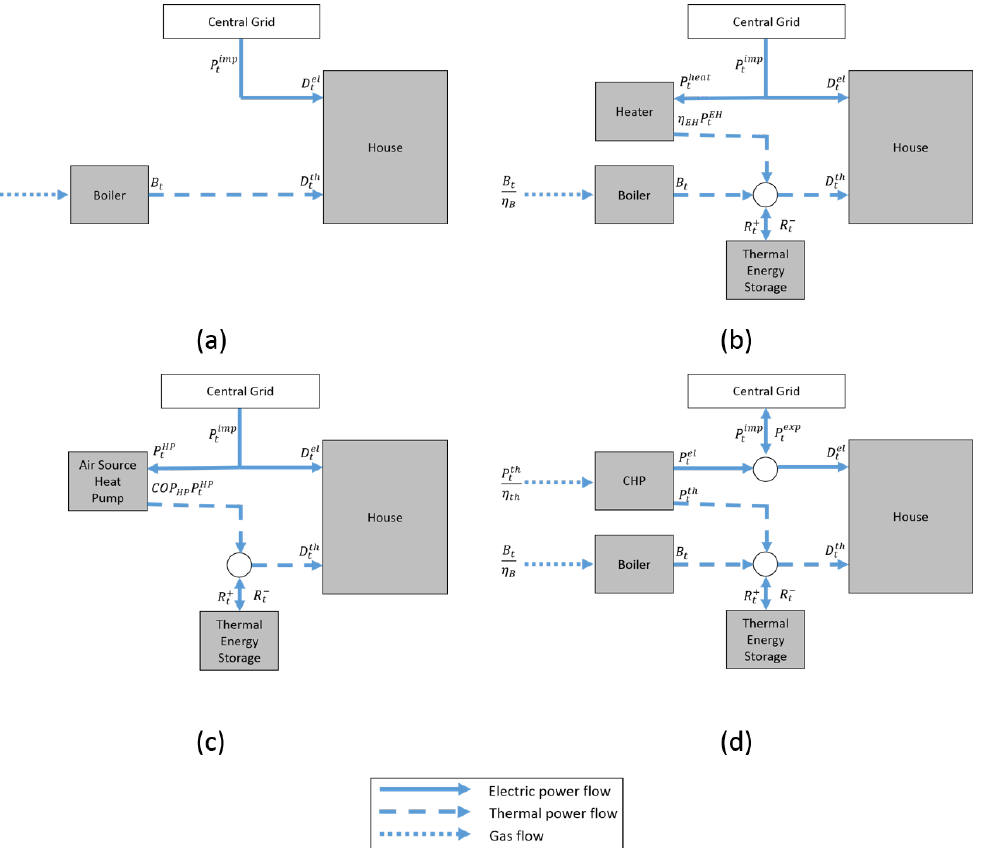
Figure 2. Heating system schematics ( a ) Reference ( b ) Electric heater ( c ) Air source heat pump ( d ) Micro-CHP.